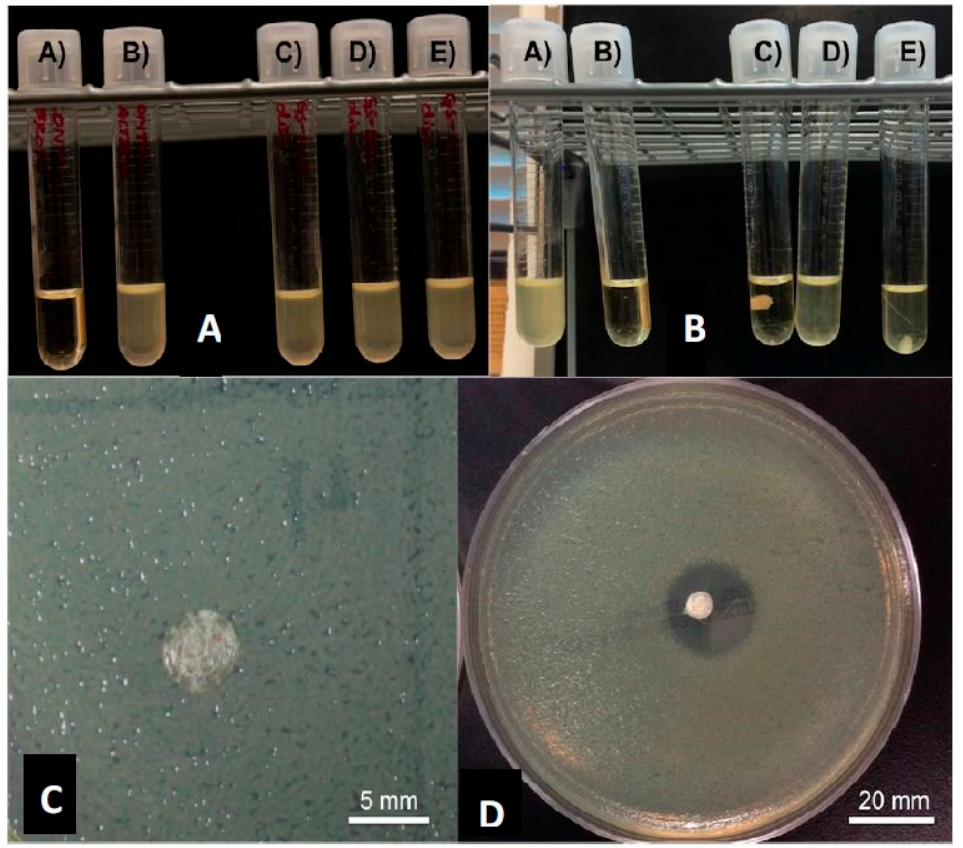
Figure 5. ( A ): (A) Sterile broth, (B) E. coli inoculated broth (C–E) 1.5 wt % GS-loaded HNT-PLA discs. ( B ): (A) E. coli inoculated broth; (B) sterile broth; (C–E) 7.5 wt % GS-loaded HNT-PLA discs. ( C ): 1.5 wt % HNT loaded with gentamicin disc; ( D ): 7.5 wt % GS-loaded HNT loaded disc.